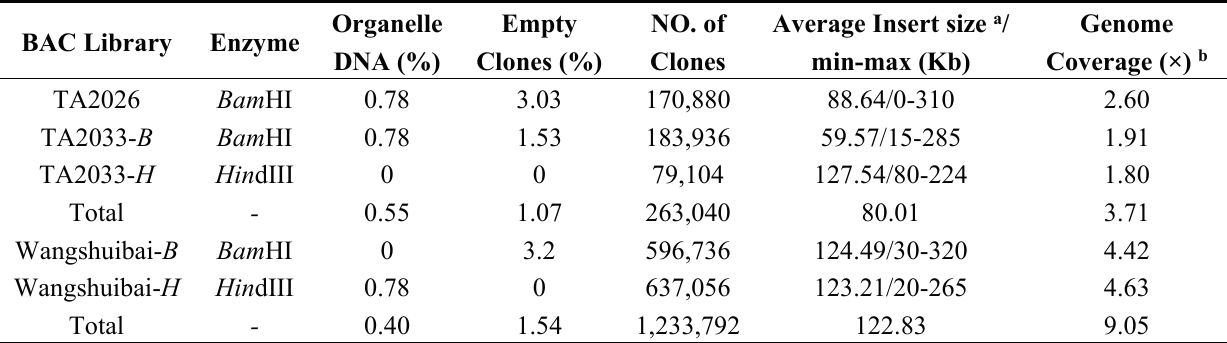
Table 2. Characteristics of the three BAC